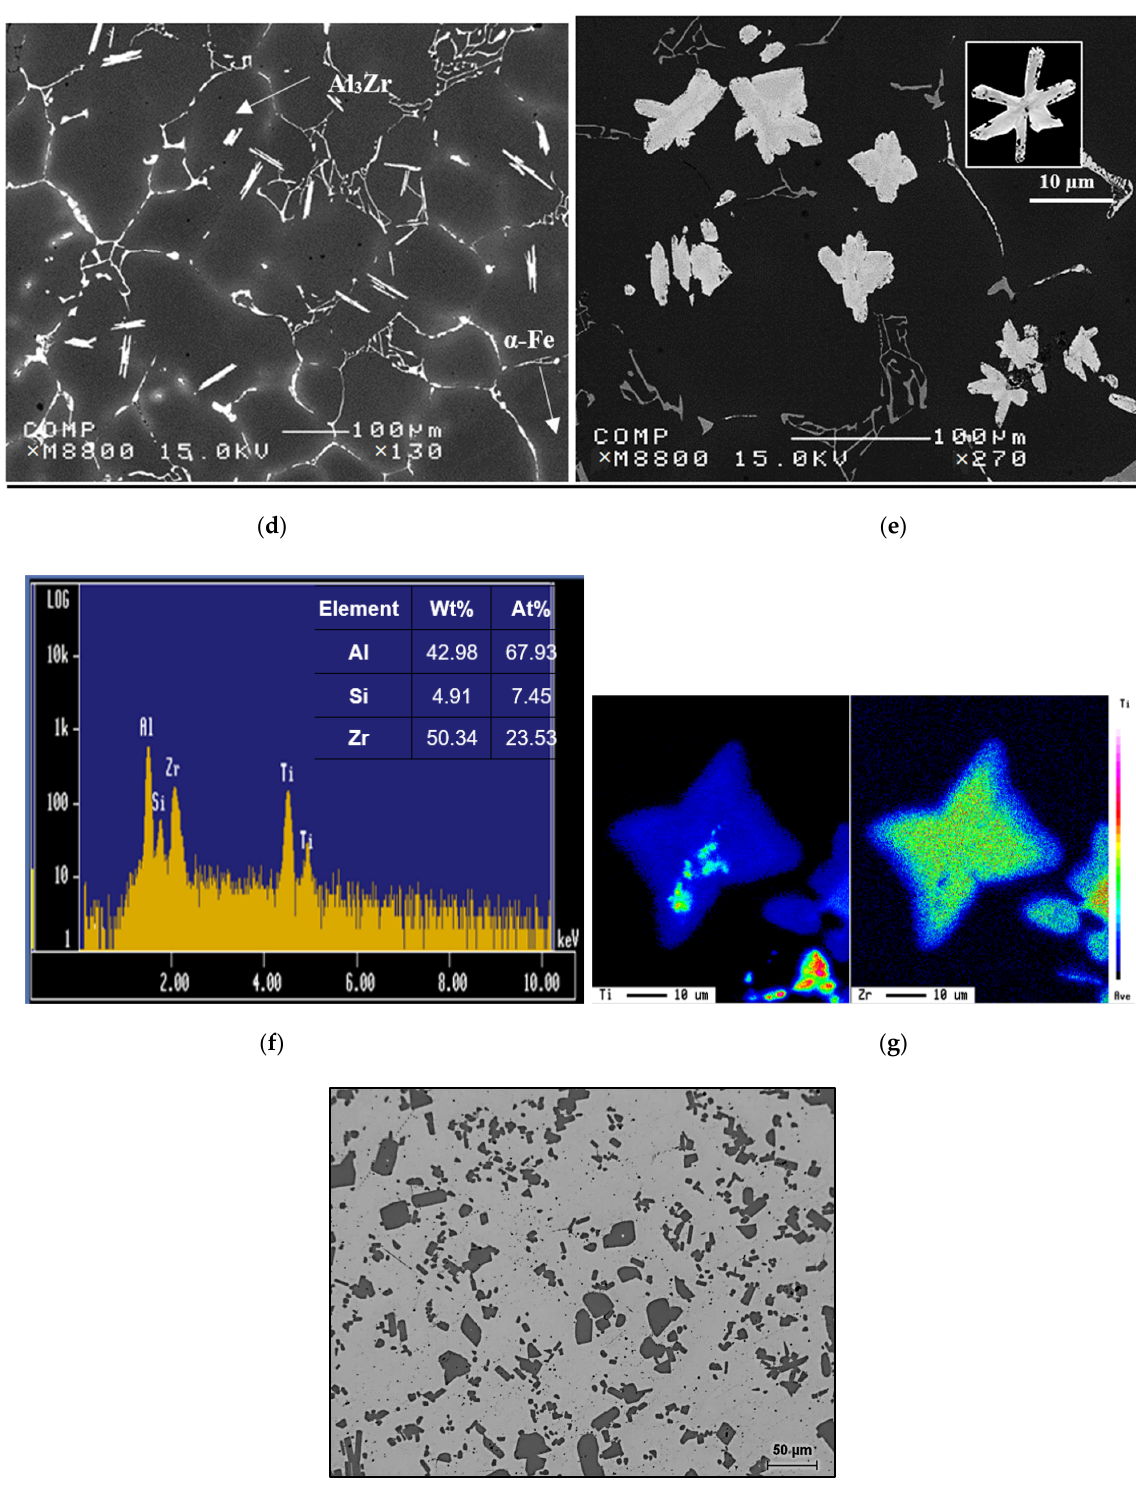
Figure 2. ( a ) Solidification curve and first derivative of the 220A base alloy. ( b – e ) SEM images showing the alloy microstructure of: ( b , c ) 220A, ( d ) 220L, and ( e ) 220M alloys—see the inset micrograph in ( e ) highlighting a star-like particle; ( f ) EDS spectrum corresponding to the star-like particles in ( e ); ( g ) Zr and Ti distributions in the star-like particle; ( h ) optical micrograph showing the microstructure of the Al-15% Zr master alloy used in this